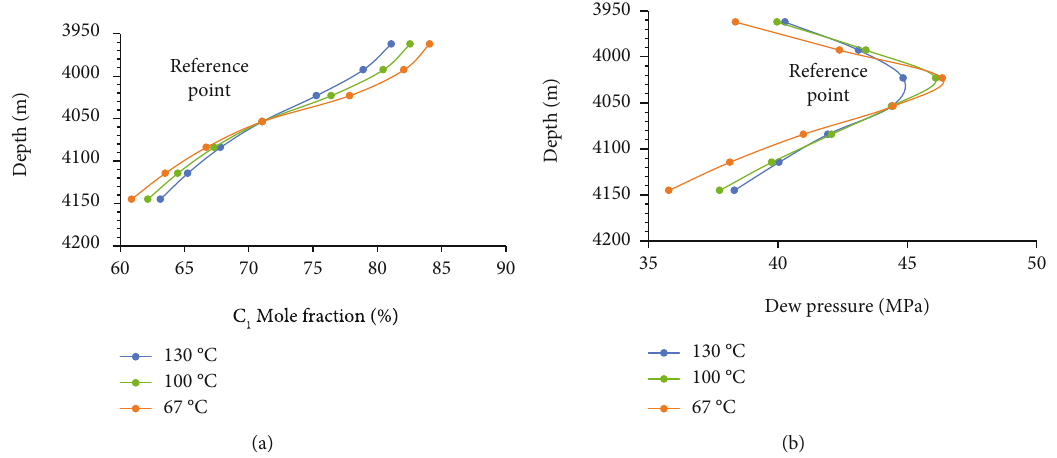
ff erent fl uid samples.